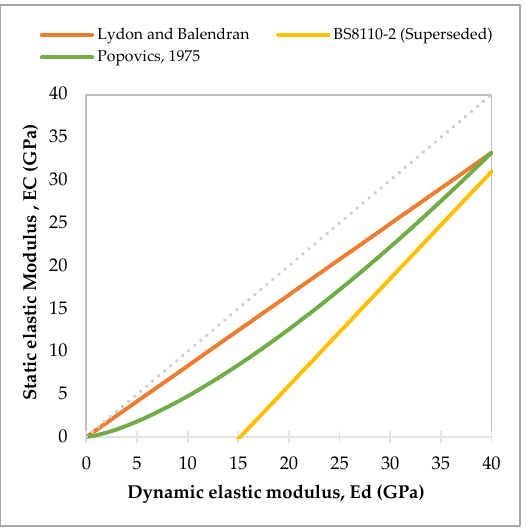
Figure 1. Correlation between Static and Dynamic modulus (Equations (5)–(7)) [43] .